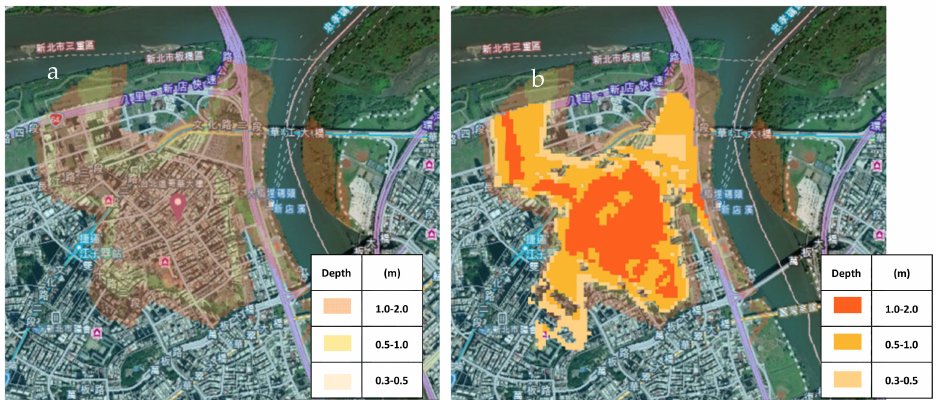
Figure 5. Comparison between ( a ) FGWAP and ( b ) 2D hydraulic modeling overlaid FWGAP. Method 2 : historical flooding